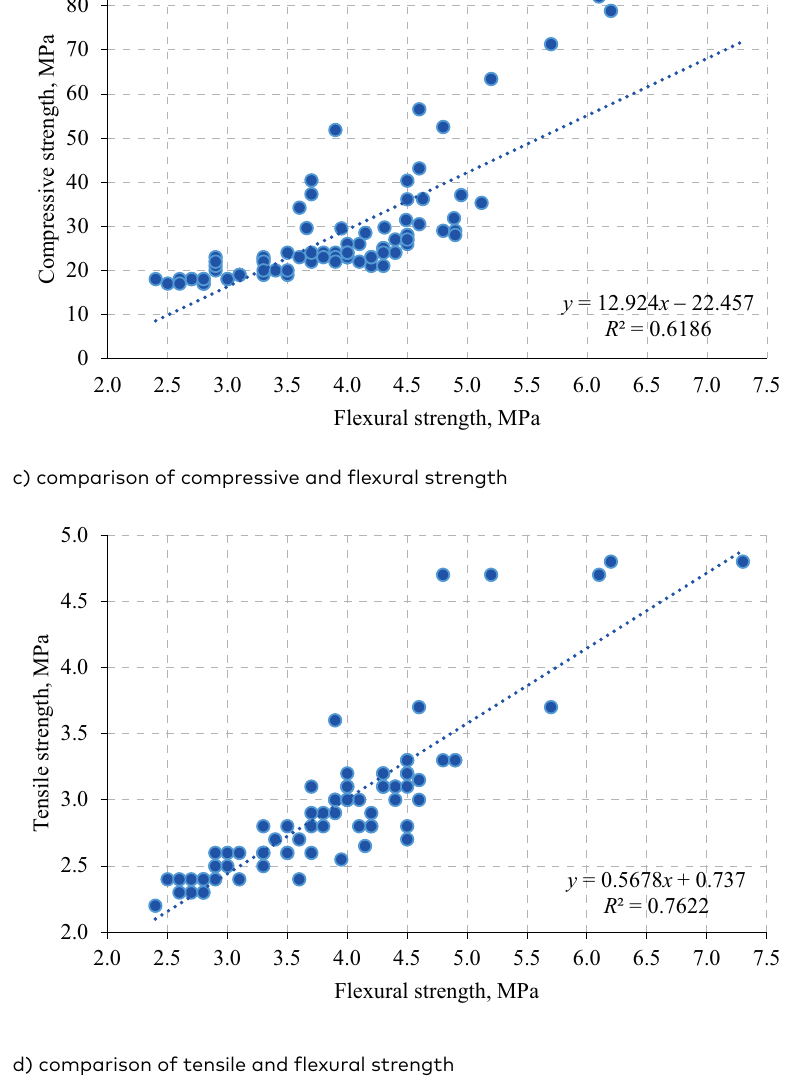
Figure 2. Summary of the analysis of concrete mixture influence